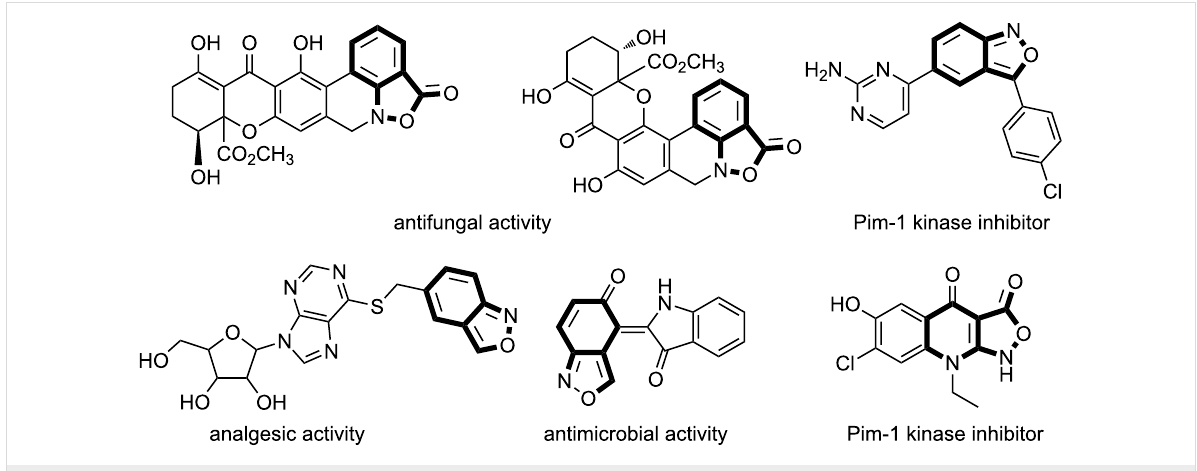
Figure 1: Selected examples of biologically active, fused 2,1-isoxazole